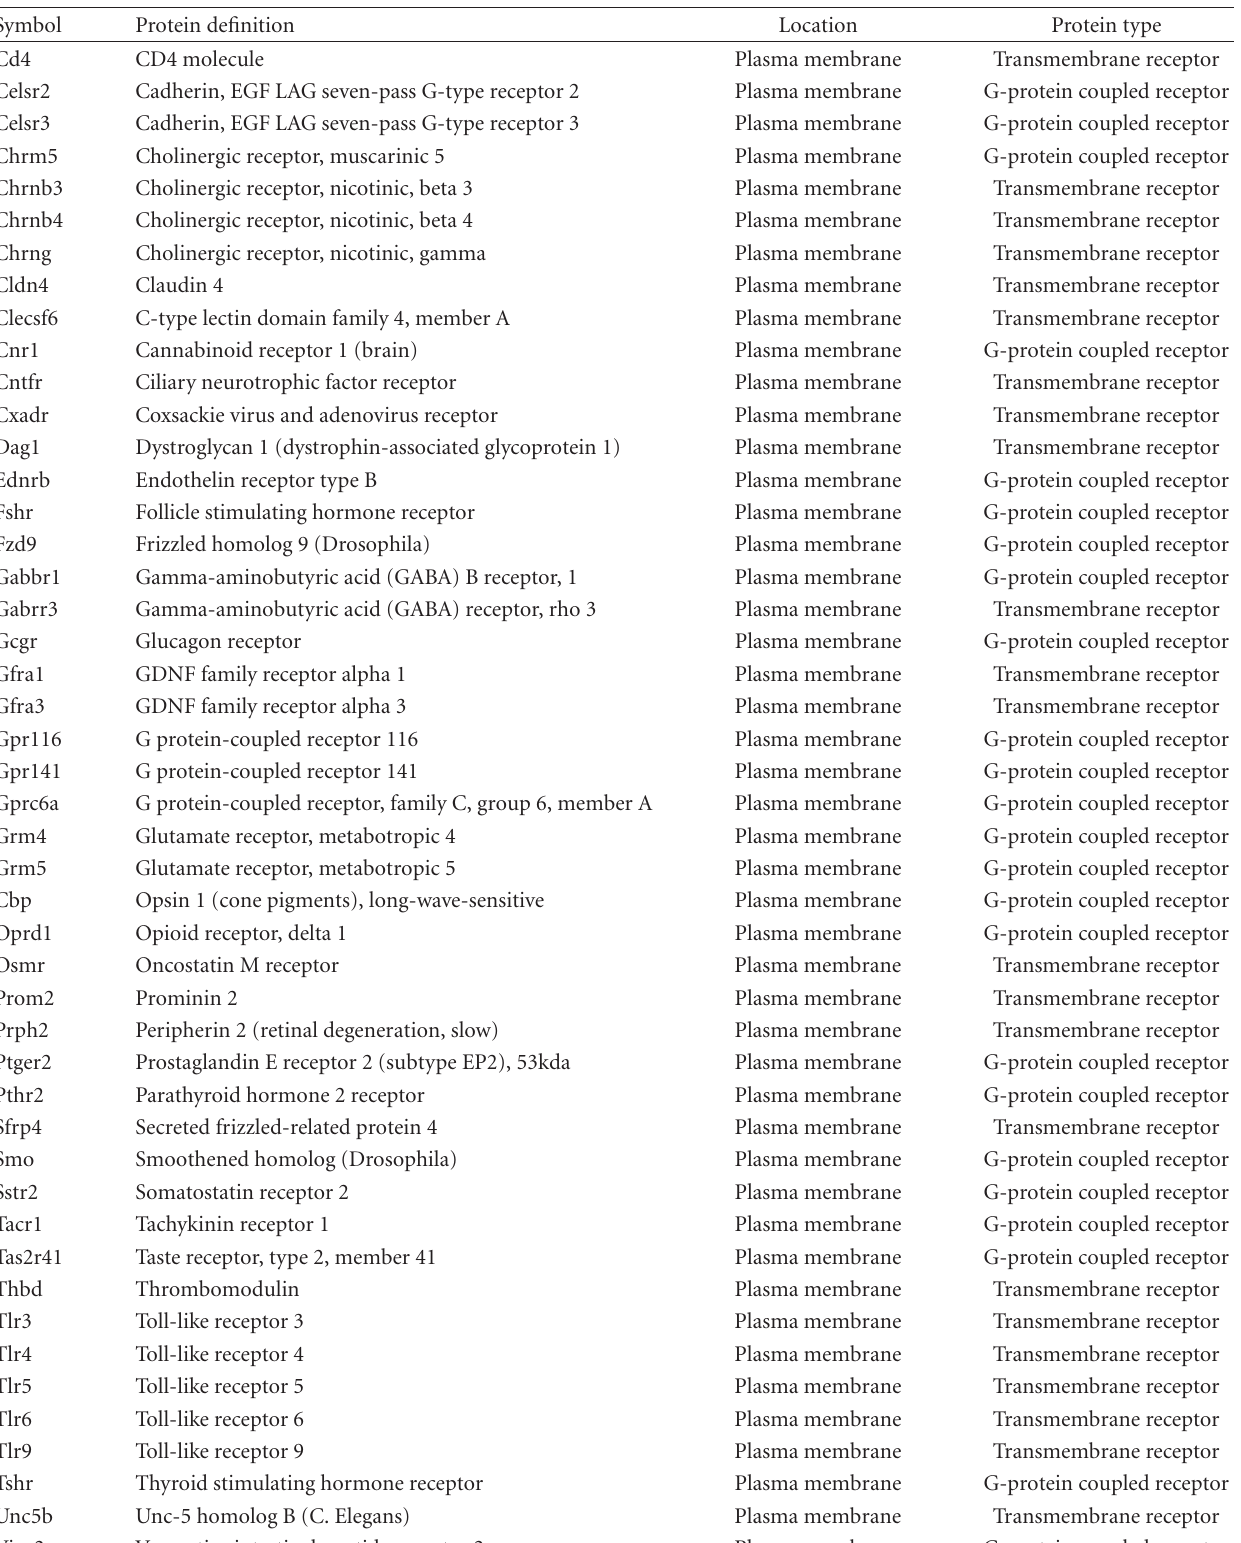
Table 1: Receptor-specific protein list from lipid raft extracts from control animals . Primary protein lists of extracted lipid raft proteins were filtered for a specific receptor profile using IPA v.